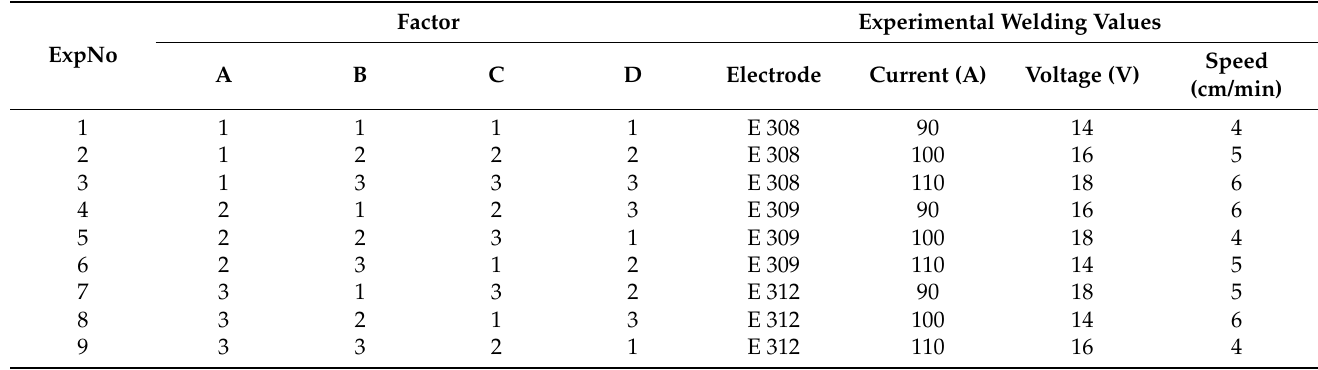
Table 3. Experimental layout and factor distribution of the orthogonal array